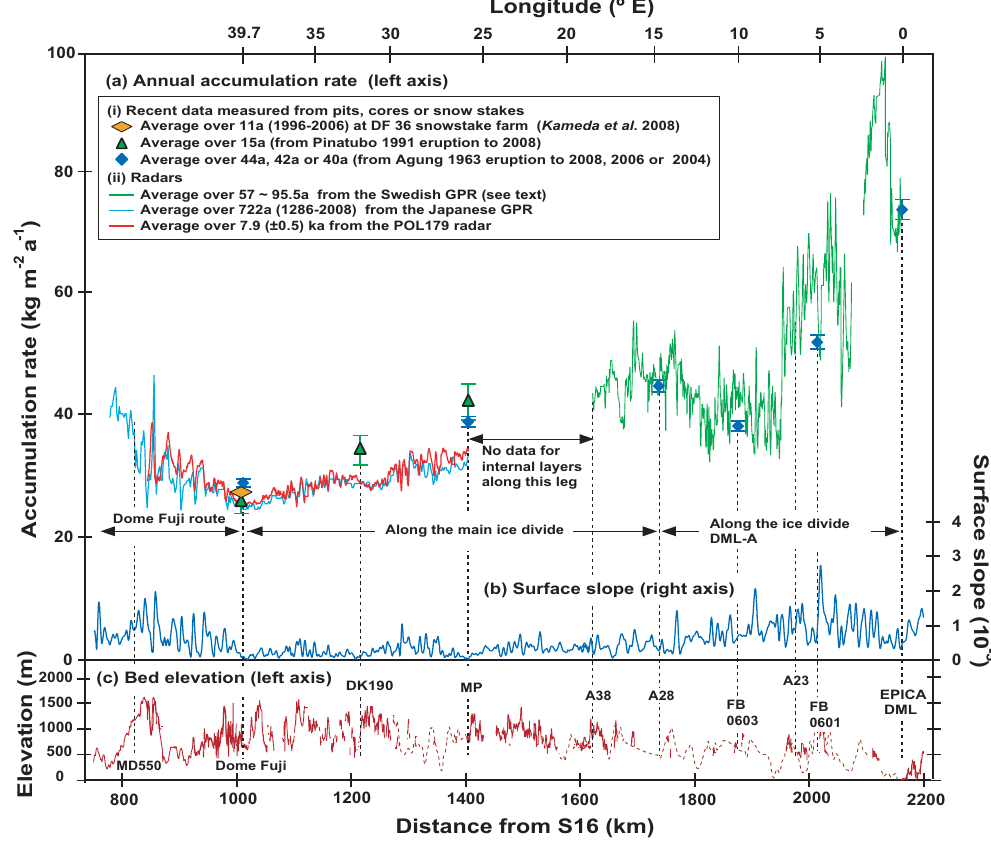
Fig. 3. Annual accumulation rates over various time scales are shown with indicators of the depositional environment along the main route of the traverse. The abscissa represents distance from S16 along the traverse route. Details are as follows. (a) Annual accumulation rate averaged over various time scales. Pit studies and firn core studies provided accumulation rates averaged over 44yr and/or 15yr (see text). Also shown is the annual accumulation rate averaged over 11yr from 1996 to 2006 (Kameda et al., 2008) from a stake farm with 36 stakes at Dome Fuji. Subsurface radars provide annual accumulation rates averaged over 57–96yr, ∼ 722yr and 7.9kyr. Details are given in the text. (b) Surface slope at each point along the route was calculated using the digital elevation model of Bamber et al. (2006). (c) Bed elevation derived from radar